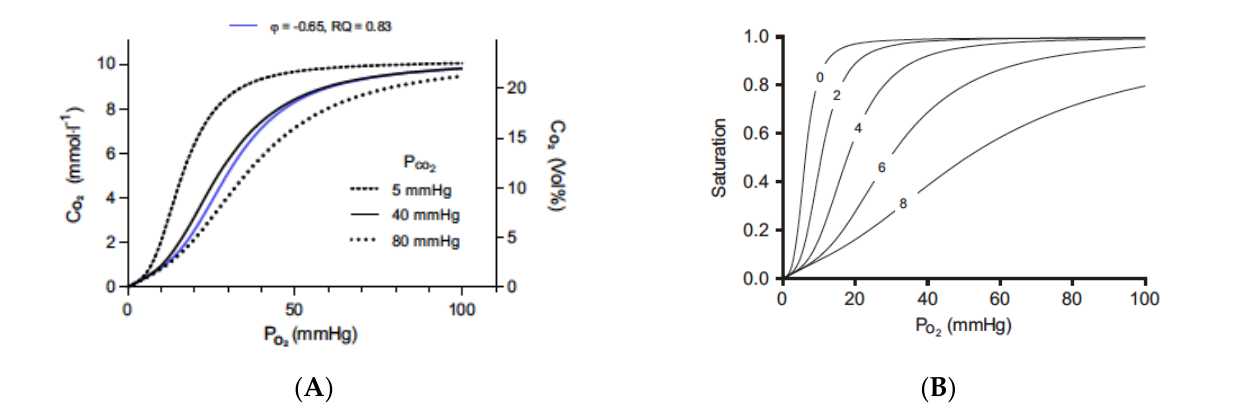
Figure 1. The Bohr effect, as defined by CO 2 and protons. The Bohr and Haldane effects have been modeled to describe the interactions between O 2 and CO 2 binding to hemoglobin [72]. The Bohr effect describes how O 2 binding is decreased in the presence of CO 2 and protons. Graph ( A ) shows the traditional oxygen ( A ) equilibrium curves modeled under different levels of CO 2 . The three black curves are the oxygen equilibrium curves obtained when the partial pressure of CO 2 is held constant at the indicated values. The blue curve is obtained when CO 2 is added at the same time as oxygen is removed at a gas exchange ratio, respiratory quotient (RQ), of 0.83. Graph ( B ) shows the effect of protons (B) on binding with a constant PCO 2 value of 40 mmHg and pH 7.2 at a PO 2 of 100 mmHg. Protons bind to the Bohr groups on the hemoglobin. The five oxygen equilibrium curves are obtained by increasing the number of bound Bohr groups (i.e., protons bound), as indicated by the numbers on the curves. The pH is not displayed because it is a poor indicator of proton binding. As protons are bound to hemoglobin, the pH increases. Figures are reprinted/adapted with permission from Ref. [72]. Copyright year 2018, Journal of Applied Physiology.